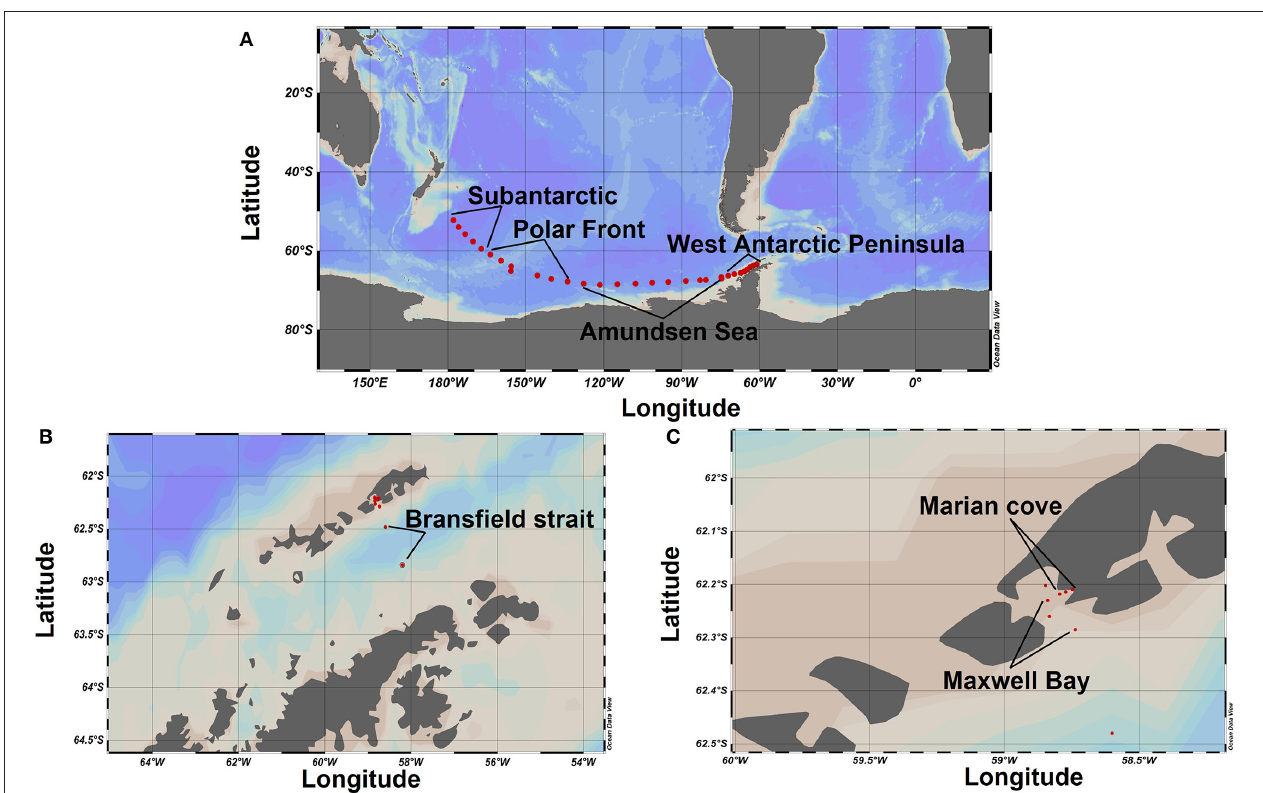
FIGURE 1 | Study areas and sampling sites. (A) Transect Christchurch, New Zealand, to the West Antarctic Peninsula. (B) Bransfield Strait. (C) Transect from Maxwell Bay to Marian cove